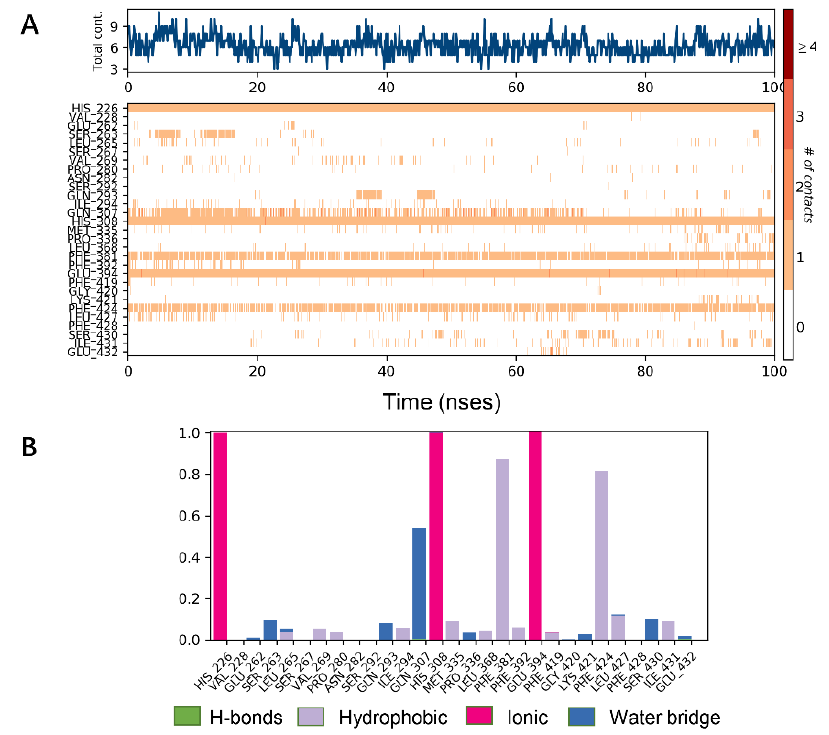
Figure 7. Molecular dynamics (MD) simulations results of 5YY6 protein and its ligand benquitrione. ( A ) Protein–ligand contacts; ( B ) bar charts of protein–ligand (P–L) contacts.